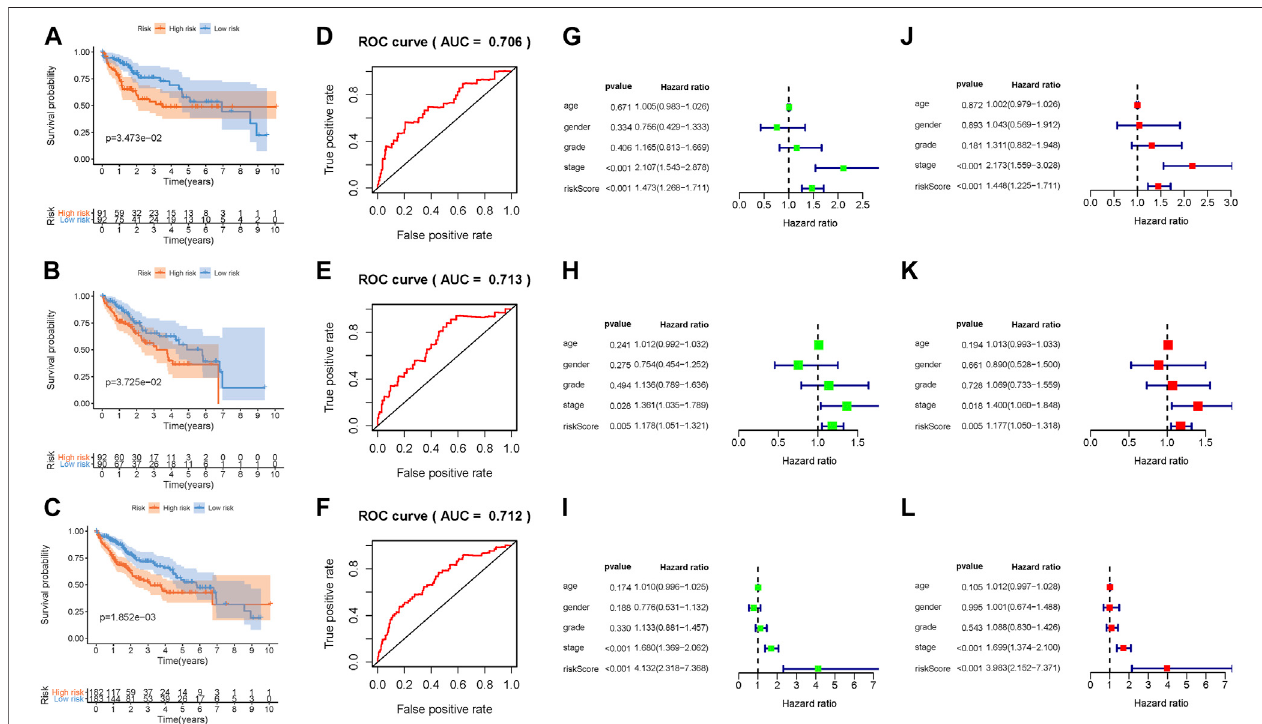
FIGURE3| DevelopmentoftheprognosticrisksignaturebasedonDNAmethylation.Kaplan – Meiercurveanalysispresentingdifferenceofoverallsurvivalbetween the high-risk and low-risk groups in the training group (A) , testing group (B) , and combination cohort (C) . ROC curve analysis of the risk scores for overall survival predictive signi fi cance in the training group (D) , testing group (E) , and combination cohort (F) . The AUC was calculated for ROC curves, and sensitivity and speci fi city were calculated to assess score performance. Univariate Cox regression analyses of overall survival in the training group (G) , testing group (H) , and combination cohort (I) . Multivariate Cox regression analyses of overall survival in the training group (J) , testing group (K) , and combination cohort (L)